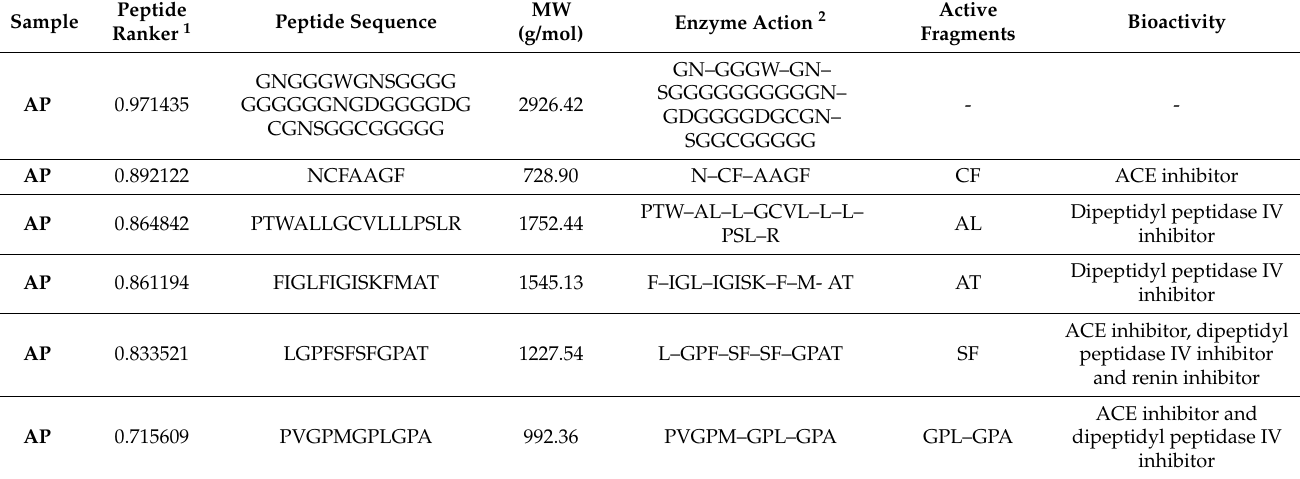
Table 1. In silico study of the identified peptides in chicken blood hydrolysates.